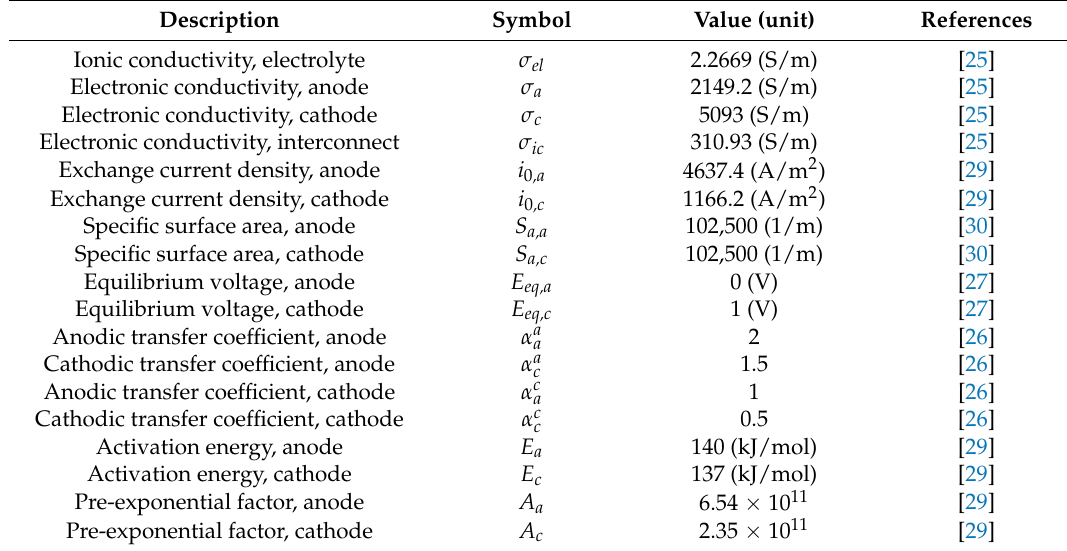
Table 3. Electrochemical parameters.